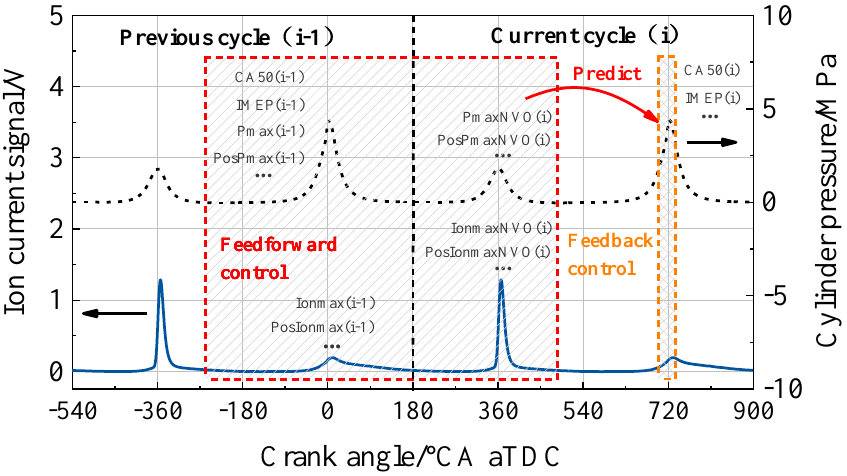
Figure 4. Concept of ion current/cylinder pressure cooperative combustion diagnosis and control (1500 r/min, IMEP = 0.3 MPa).